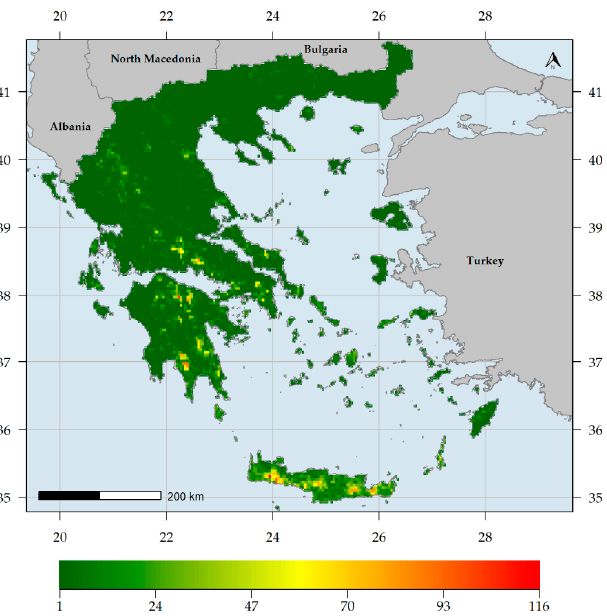
Figure 2. Endemic plant species richness in Greece (number of Greek endemic plant species per grid cell).